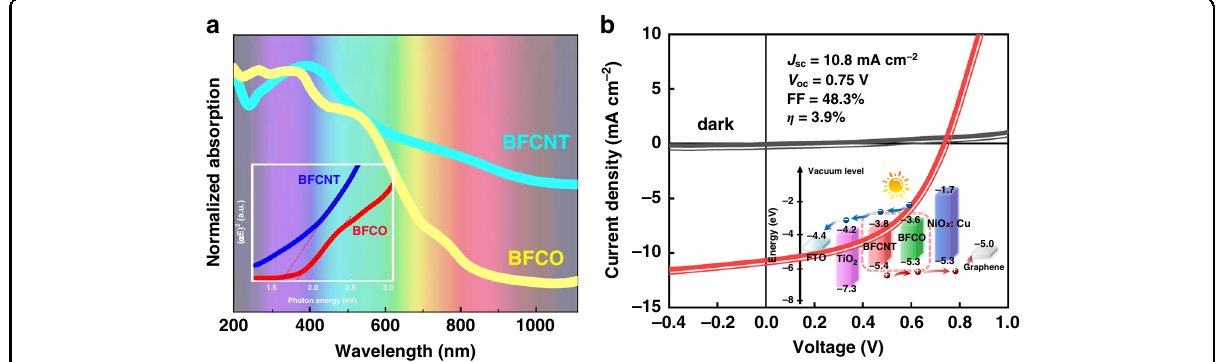
Fig. 2 The optical and photovoltaic properties. a UV-Vis-NIR spectra of both BFCNT and BFCO, in arbitrary units (a.u.), the inset is the corresponding ( α E) 2 versus energy plots. b J-V characteristic under AM 1.5 G illumination of the solar cells. The inset shows the energy-level diagram based on UPS results showing the valence, Femi, and conduction energy of each component